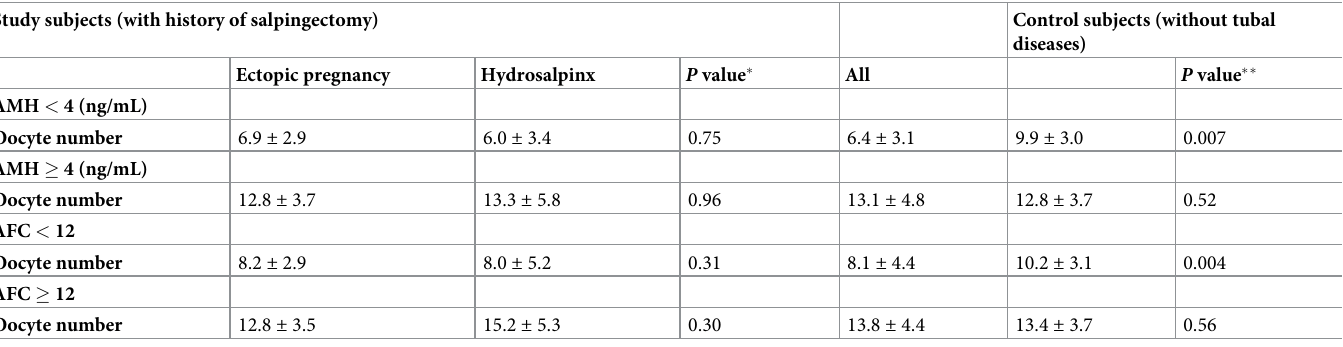
Table 3. Subgroup analysis by baseline ovarian reserve indicating the number of retrieved oocytes in women with and without salpingectomy and in women with salpingectomy and distinct indications (i.e., ectopic pregnancy vs. hydrosalpinx). Study subjects (with history of salpingectomy)